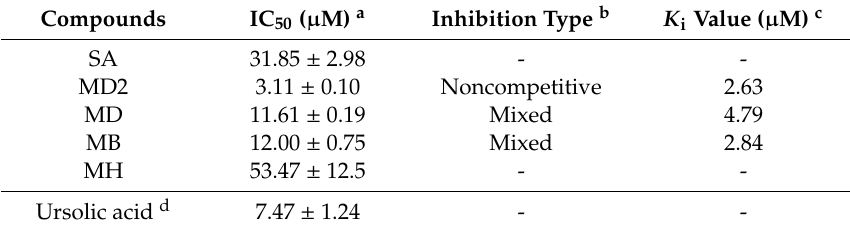
Table 1. Protein tyrosine phosphatase 1B (PTP1B) inhibitory activity of arylbenzofurans isolated from Morus